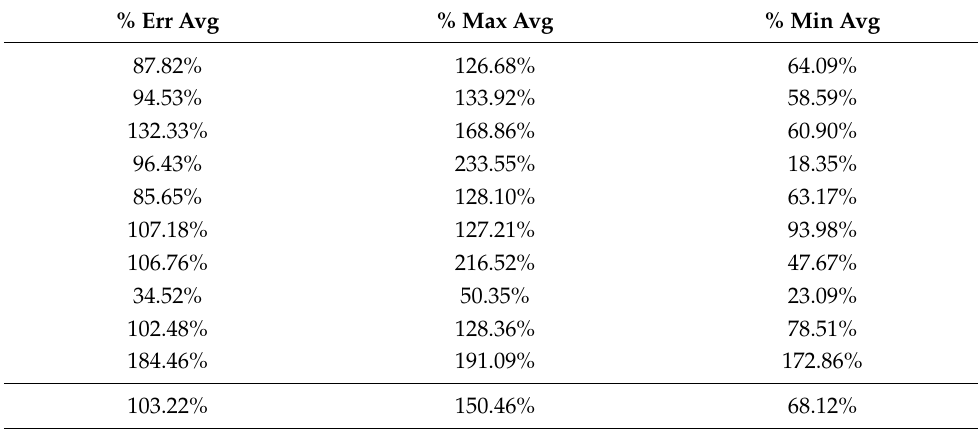
Table A28. Set 1, trials 11–20 data (average actual PR values).